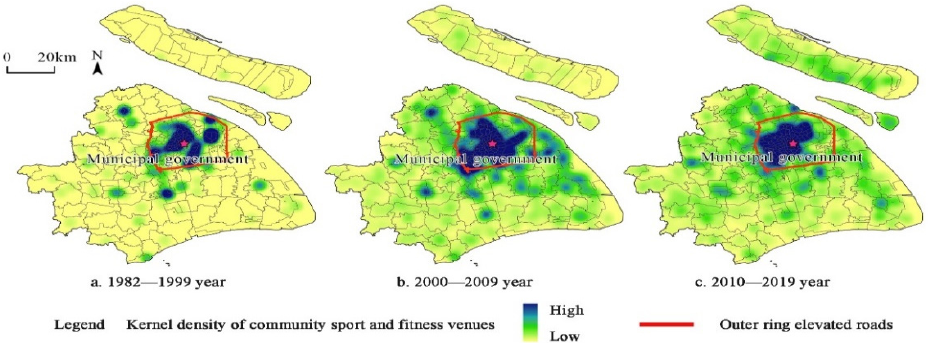
Figure 3. Spatial-temporal evolution of kernel density of Shanghai’s community sports and fitness venues.